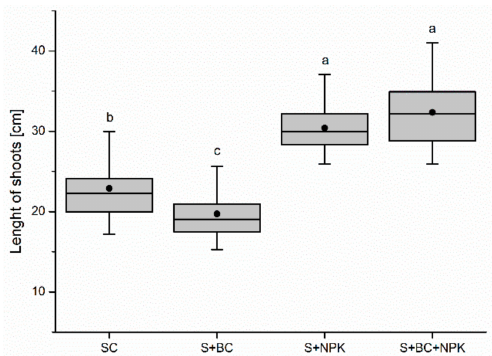
Figure 3. E ff ect of biochar and fertilizer on grass shoots length: Data from the last measurement (77th day of experiment). Dots indicate mean values, horizontal lines in boxes indicate median. Letters indicate significant di ff erences among the treatments ( p =